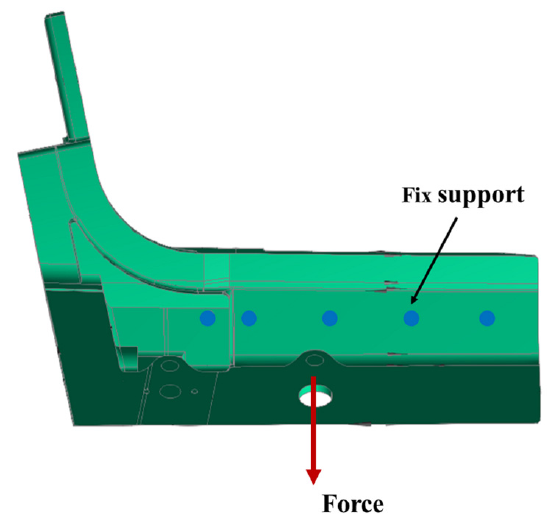
Figure 11. Boundary conditions of buckling analysis.